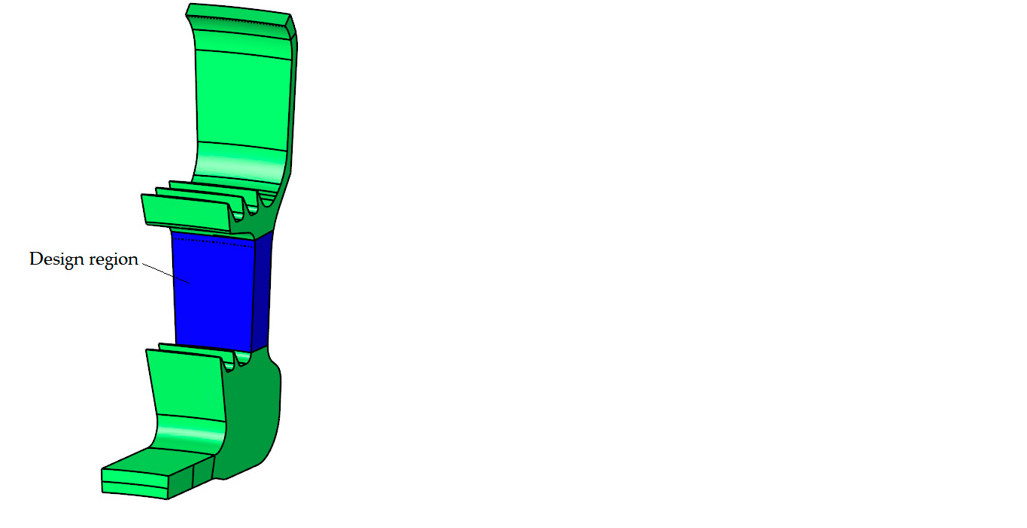
Figure 2. Cyclically symmetric sector sub-model of the studied HPT sealing disk.